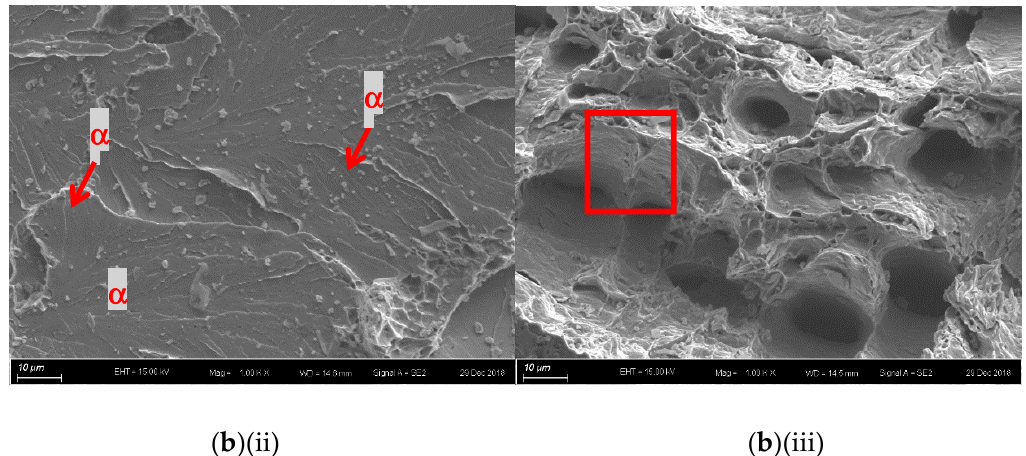
Figure 8. SEM fractographs of laser-surface melted AISI 430 steel (V80) ( a ) without hydrogen pre-charging, (b )(i) with hydrogen pre-charging, ( b )(ii) MZ of ( b )(i), and (iii) substrate of ( b )(i).